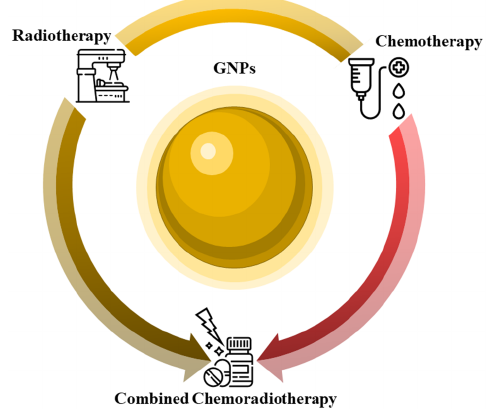
Figure 1. Gold nanoparticle-based cancer therapeutics. Radiotherapy and chemotherapy are the two main modalities, besides surgery, in treating cancer. However, normal tissue toxicity in both methods remains a large issue in limiting the effective dose to the tumor. Thus, gold nanomaterials have been introduced to improve the locally deposited dose into tumors and act as a drug delivery system. The combination of radiotherapy and chemotherapy, called chemoradiotherapy, allows for an optimum platform for eradicating the tumor and improving cancer